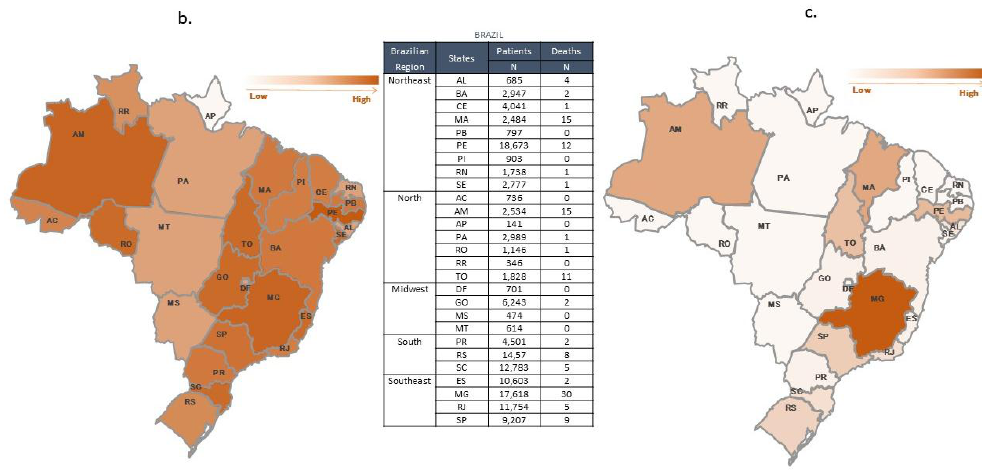
Figure 1. Foodborne disease outbreak notifications by Brazilian regions ( a ) and Brazilian states ( b ), and the number of deaths by Brazilian state ( c ). Northeast Region- AL: Alagoas, BA: Bahia, CE: Ceará, MA: Maranhão, PB: Paraíba, PE: Pernambuco, PI: Piauí, RN: Rio Grande do Norte, SE: Sergipe; North Region- AC: Acre, AM: Amazonas, AP: Amap á , PA: Par á , RO: Rond ô nia, RR: Roraima, TO: Tocantins; Midwest Region- DF: Distrito Federal, GO: Goi á s, MT: Mato Grosso, MS: Mato Grosso